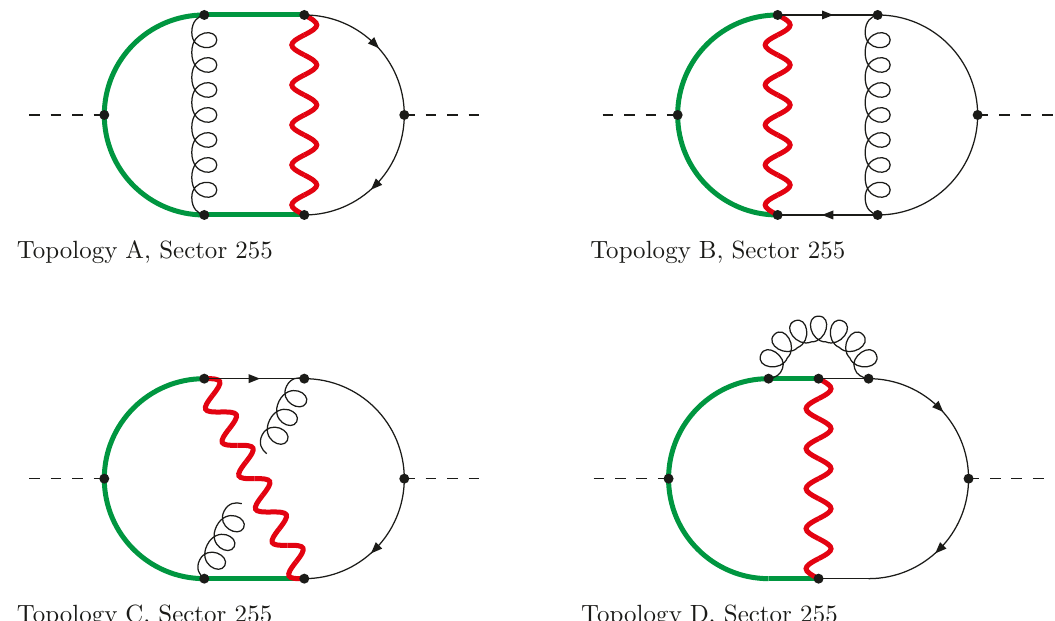
Figure 1 . Examples of three-loop Higgs self-energy diagrams containing a top propagator and a W -propagator and being proportional to the product of Yukawa couplings y b y t . The internal masses of the propagators are encoded by the colour of the propagators: massless (black), m t (green), m W